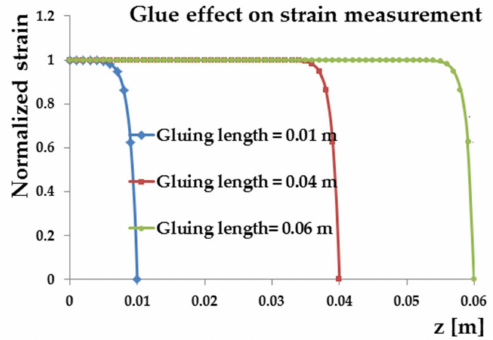
Figure 4. Effects of different gluing lengths.